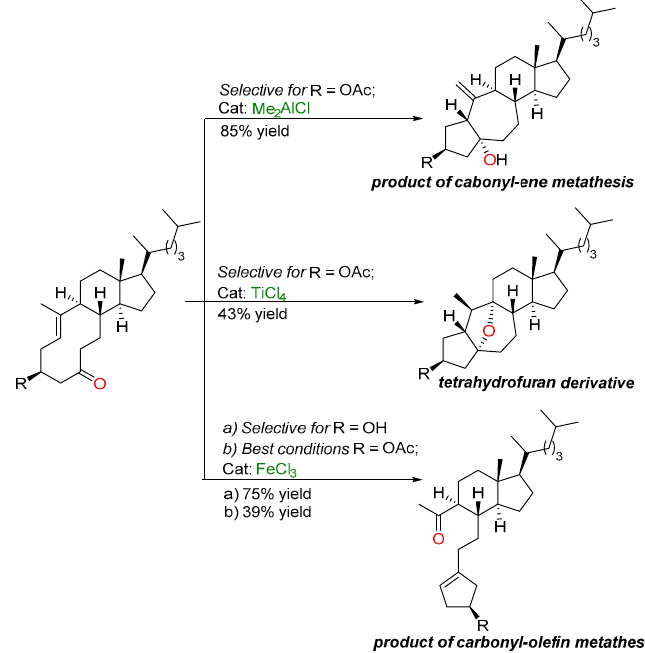
Scheme 16. Overview of possible outcomes for the conversion of chosen decalin derivative.